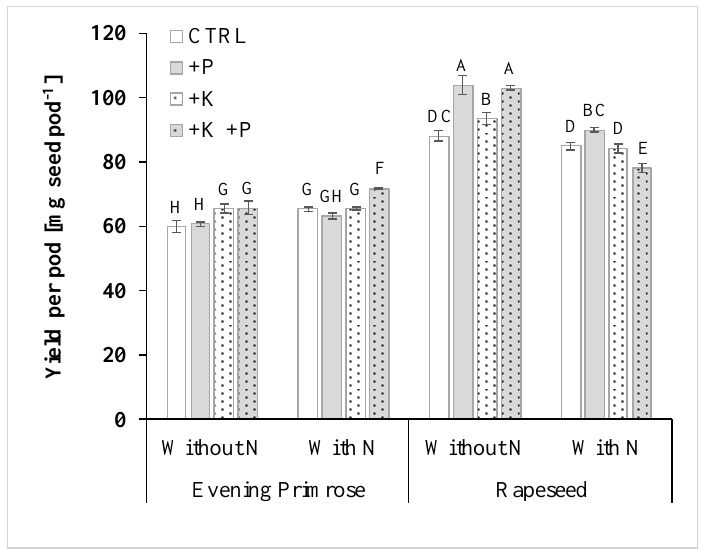
Figure 2. Least squares means (LSmeans) and standard error of the LSmeans of the grain yield per pod of Oenothera biennis L. local genotype (Evening Primrose) and Brassica napus L cv. serw 1 (Rapeseed) grown in 2 growing seasons in a P and K deficient soil and fertilized with 142.9 kg N ha −1 , 171.4 kg K 2 O ha −1 , or 36.9 kg P 2 O 5 ha − 1 . Means with a letter in common cannot be considered different according to a conservative Tukey-grouping applied to the p differences of the LSmeans. N = 6. Please note that error bars are standard error estimates of the LSmeans and not the computed standard error, which can be found in Supplementary Materials Table S1. CTRL indicates a lack of P and K applications.